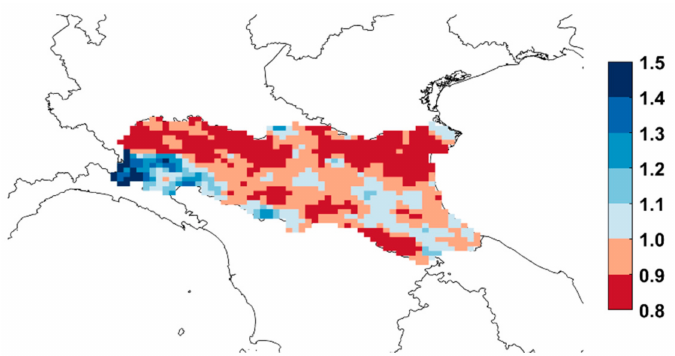
Figure 16. Factors of change for p r,k for the time window 1981–2020 in comparison with the reference time interval